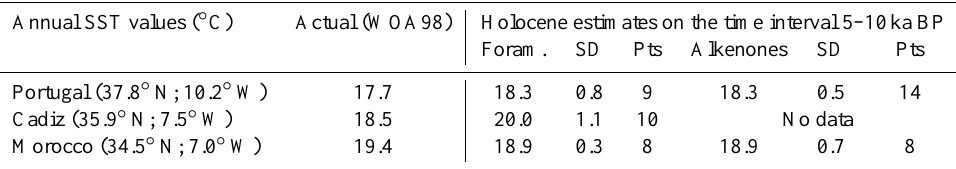
Table 2. Mean SST values reconstructed for the Holocene (5–10ka BP) from foraminifera ( n = 1007) and alkenones (Prahl et al., 1988) on the three cores versus present-day SST values from World Ocean Atlas 1998 (WOA98). SD: Standard Deviation; Pts: Number of points used for the